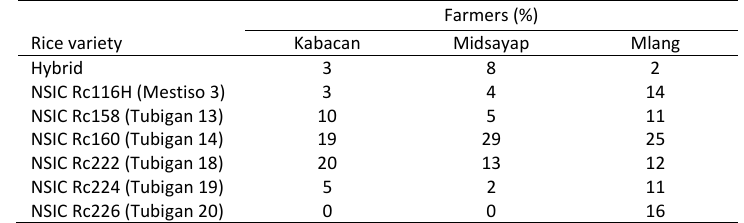
Table 3: Rice varieties commonly planted by farmers for the last 4 cropping seasons (2016‐2017) Farmers (%)